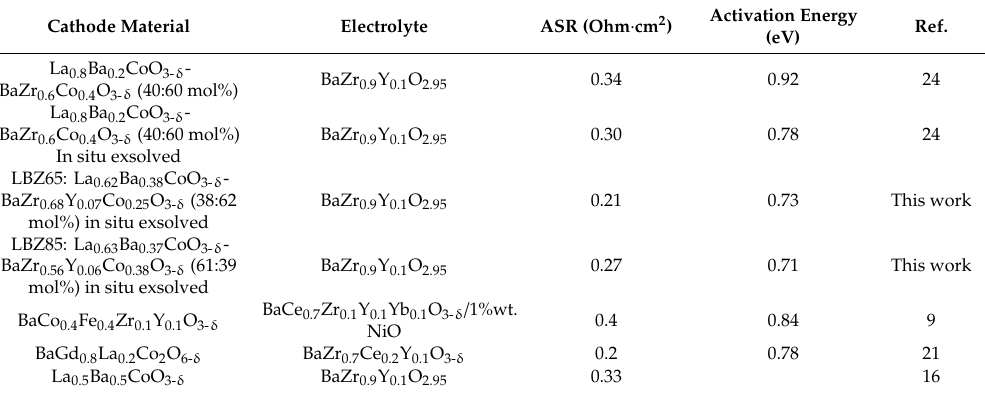
Table 4. Comparison of the cathode area specific resistance from the literature in 3% moist synthetic air at 600 ◦ C in symmetric cell